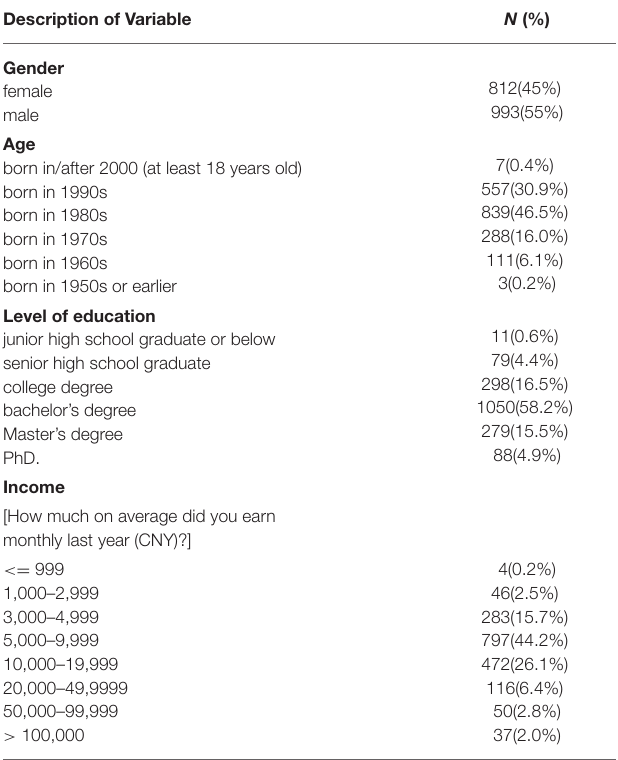
TABLE 1 | The socio-demographic characteristics of the sample. Description of